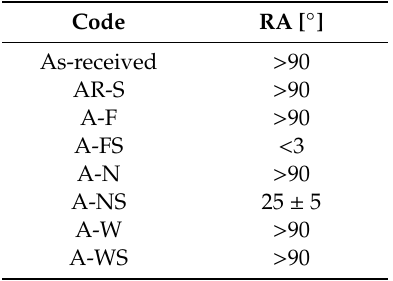
Table 4. Rolling angle (RA) for silanized aluminum alloy